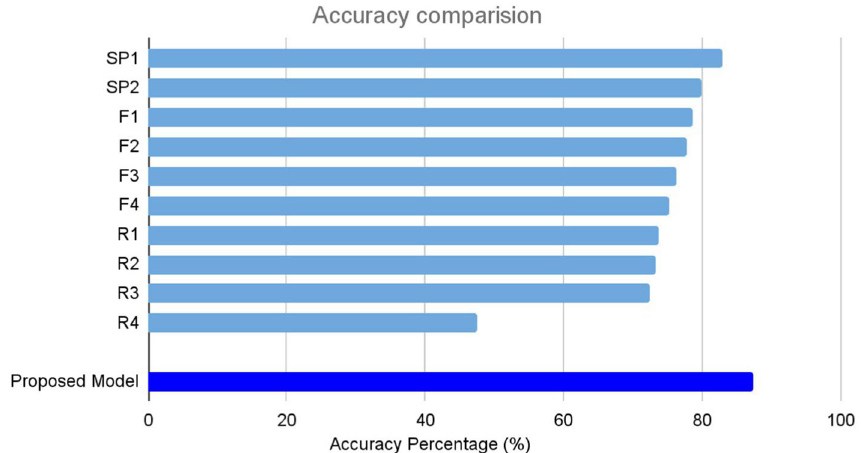
Figure 1. Comparison of classification performance with model and 10 ophthalmologists. The classification accuracy of the model was 87.4%, the highest performance compared to ten ophthalmologists. Ophthalmologists consisted of two retina specialists (RE), four retina fellows (F) and four residents (R).